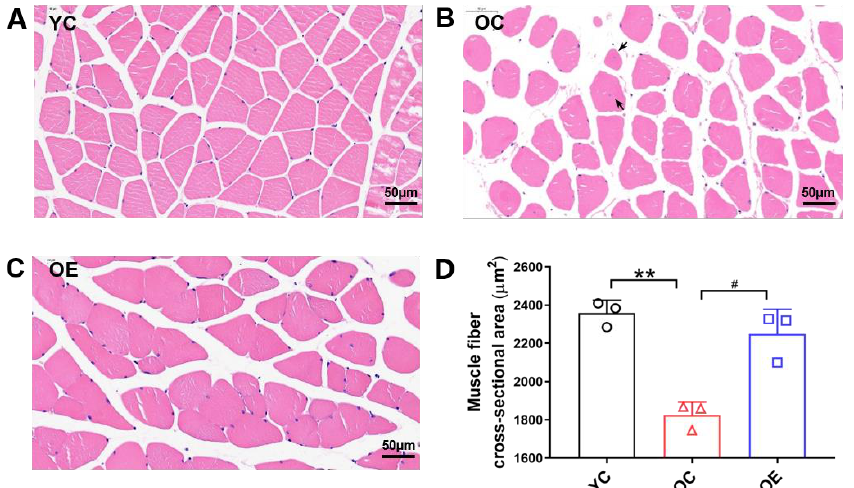
Figure 1. The skeletal muscle atrophy in aged mice evaluated by CSA of skeletal muscle fibers. ( A – C ) Representative images of skeletal muscle with HE staining (scale bar, 50 µ m) and ( D ) histogram of the CSA of skeletal muscle fibers. The black arrows present nucleus-migrated fibers. More than 150 fibers were randomly selected from at least 3 skeletal muscle samples from 3 mice in each group to measure the average CSA of skeletal fibers. All data are presented as mean ± standard deviation (M ± SD) ( n = 3 mice per group). Group symbols: YC, black circle; OC, red triangle; OE, blue square. ** p < 0.01 vs. YC group; # p < 0.05 vs. OC group.